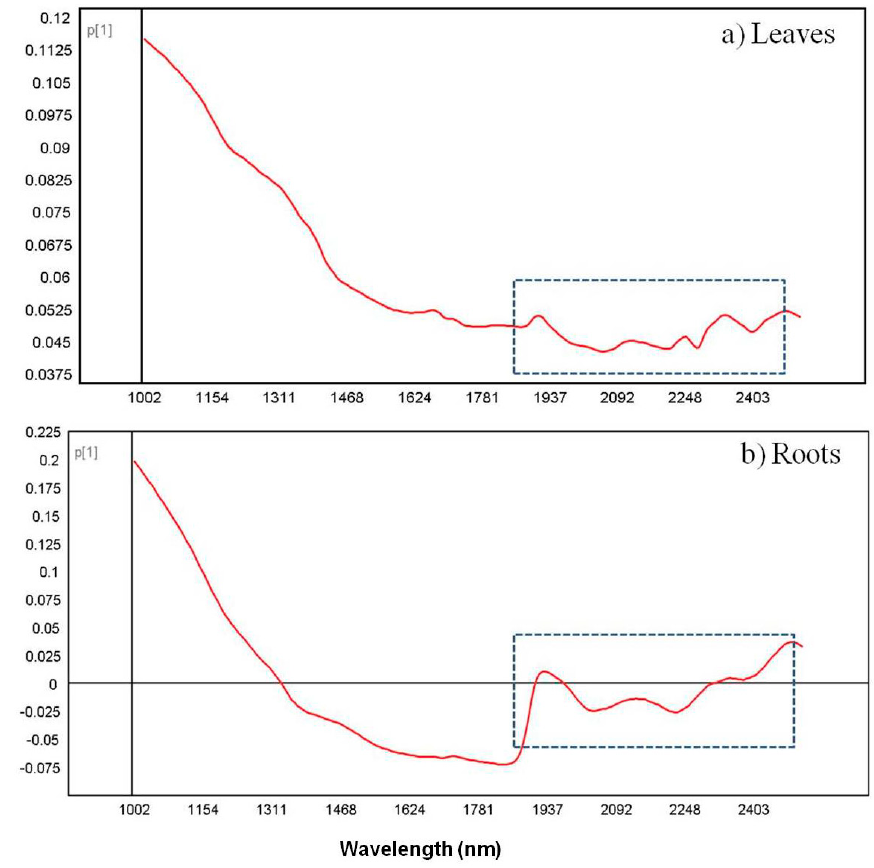
Figure 7. Loadings line plot of vector P1 for the leaf score image ( a ) and the root score image ( b ) showing variables responsible for separation of the three